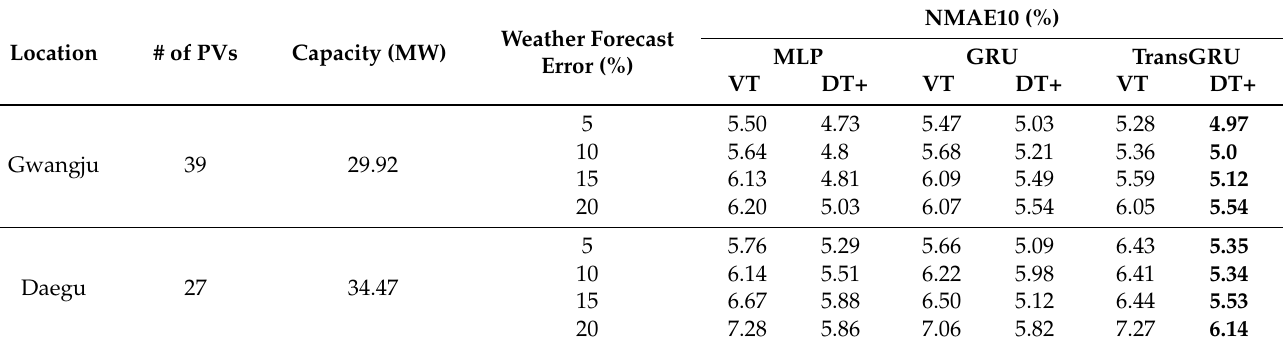
Table 5. PV forecasting error of PV